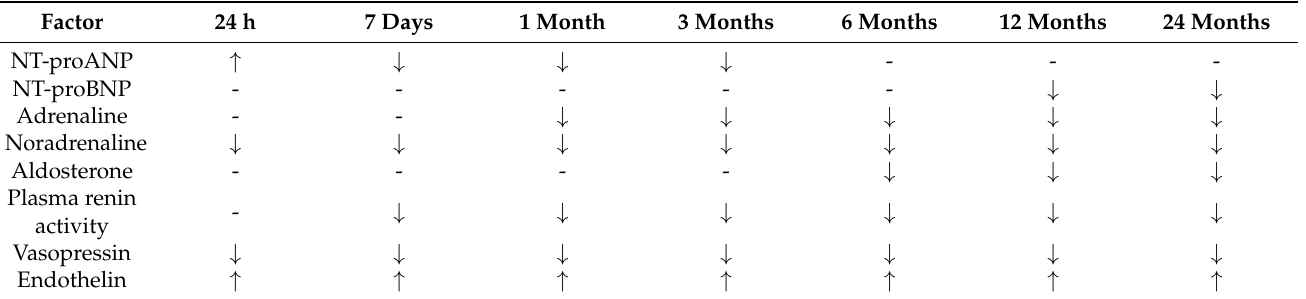
Table 4. Changes in electrolytes, natriuretic peptide, and adrenergic markers after LAAC compared to